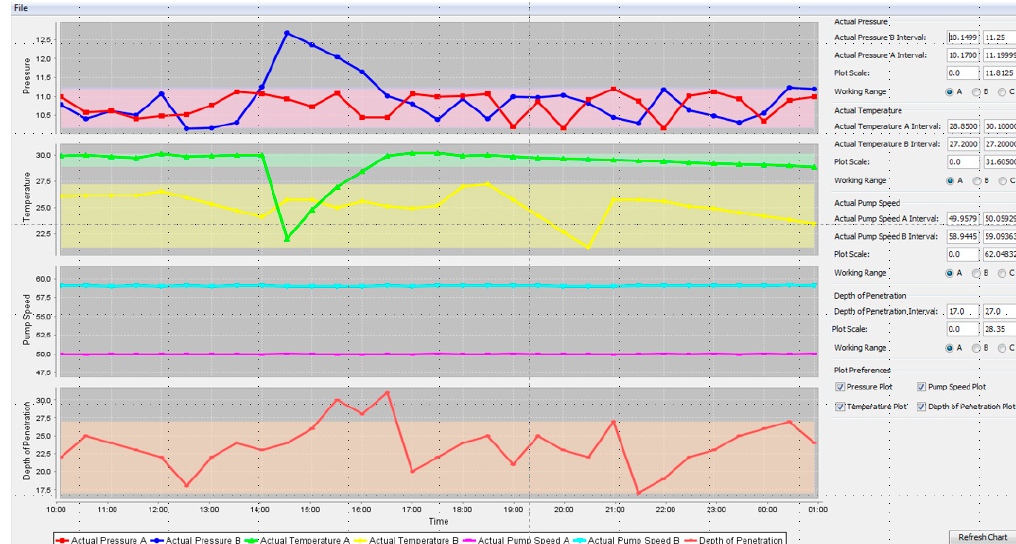
Figure 10. Results of advanced Valve Synchronization test run.